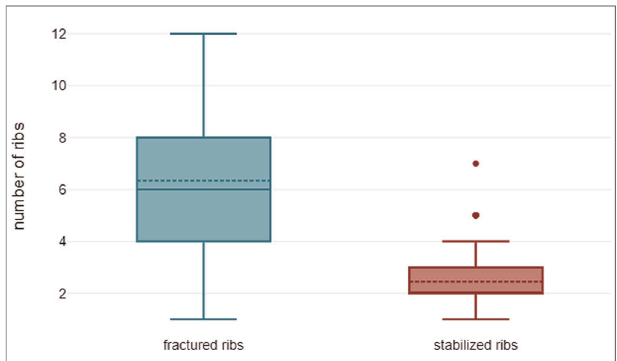
FIGURE 4 | Comparison of fractured ribs vs. stabilized ribs in all patients: mean 6.3 (±2.7) vs. 2.4 (±1.2) (